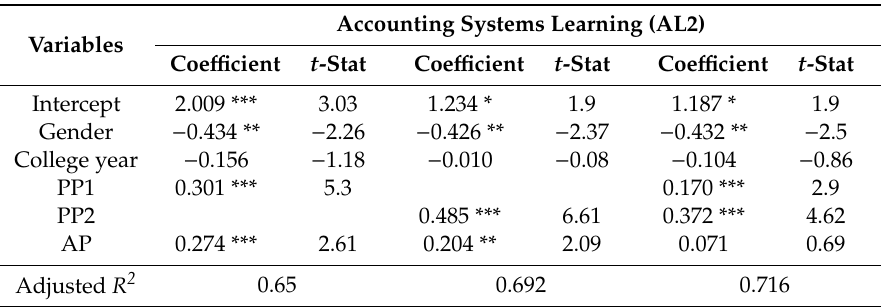
Table 9. E ff ect of positive perception on accounting systems learning—mediating e ff ect.